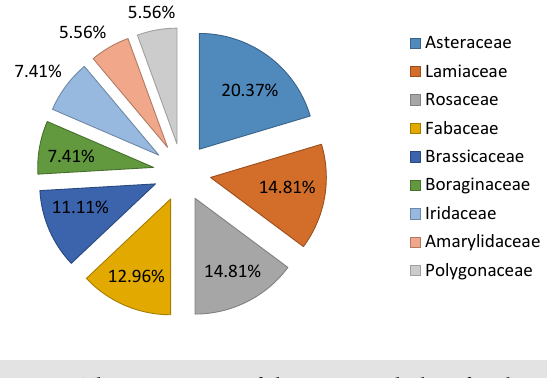
Fig. 4 The percentages of the most used plant families in Hasankeyf.